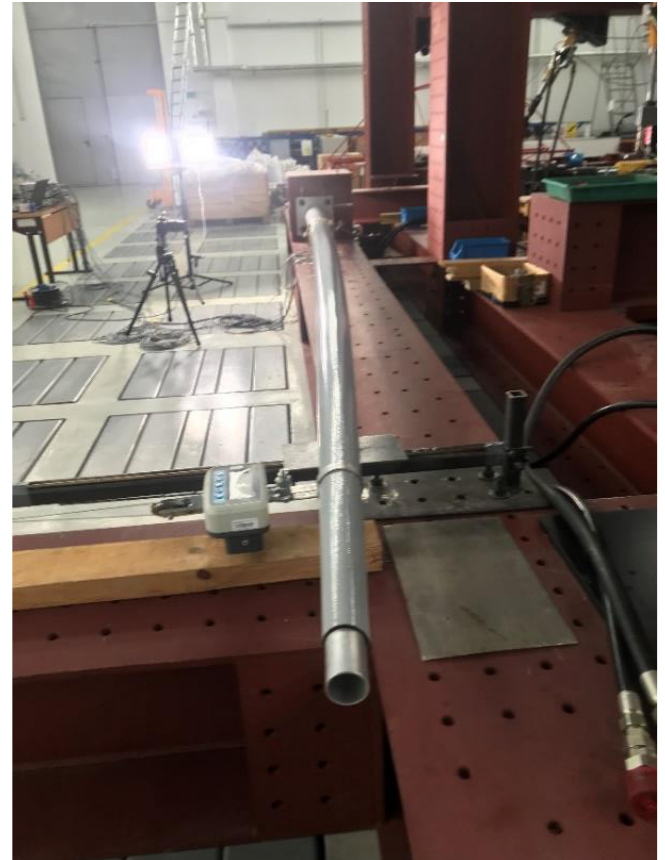
Figure 5. View of pole no. 5/2 mounted on the test stand.